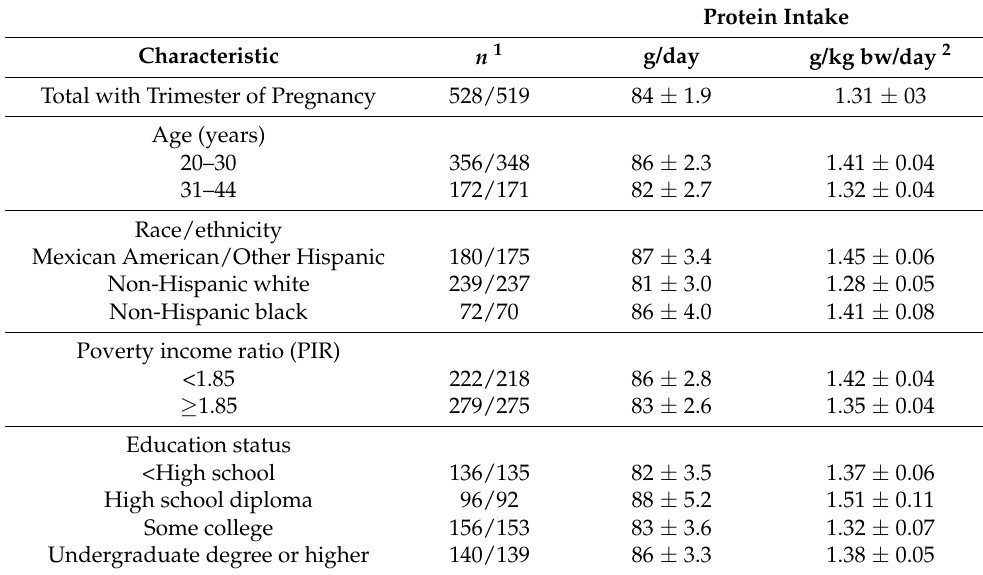
Table 3. Protein intake by demographic characteristics among pregnant women ages 20–44 years in 2003–2012 National Health and Nutrition Examination